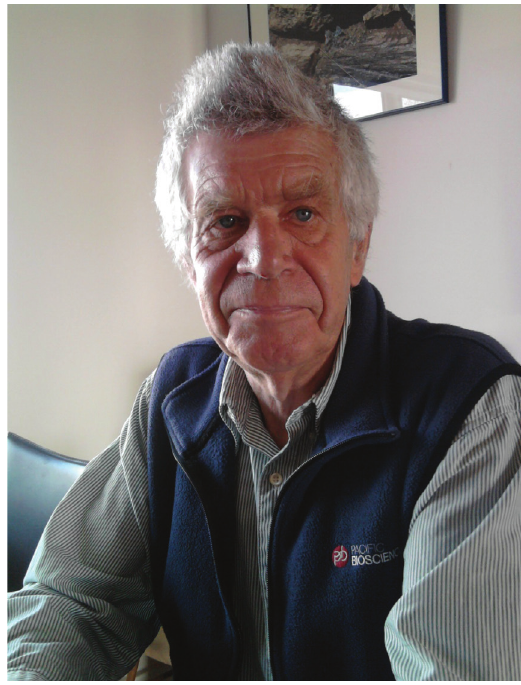
Figure 1. Harry van Oorschot, Amsterdam, 16 March 2014. Photo by Raanya de